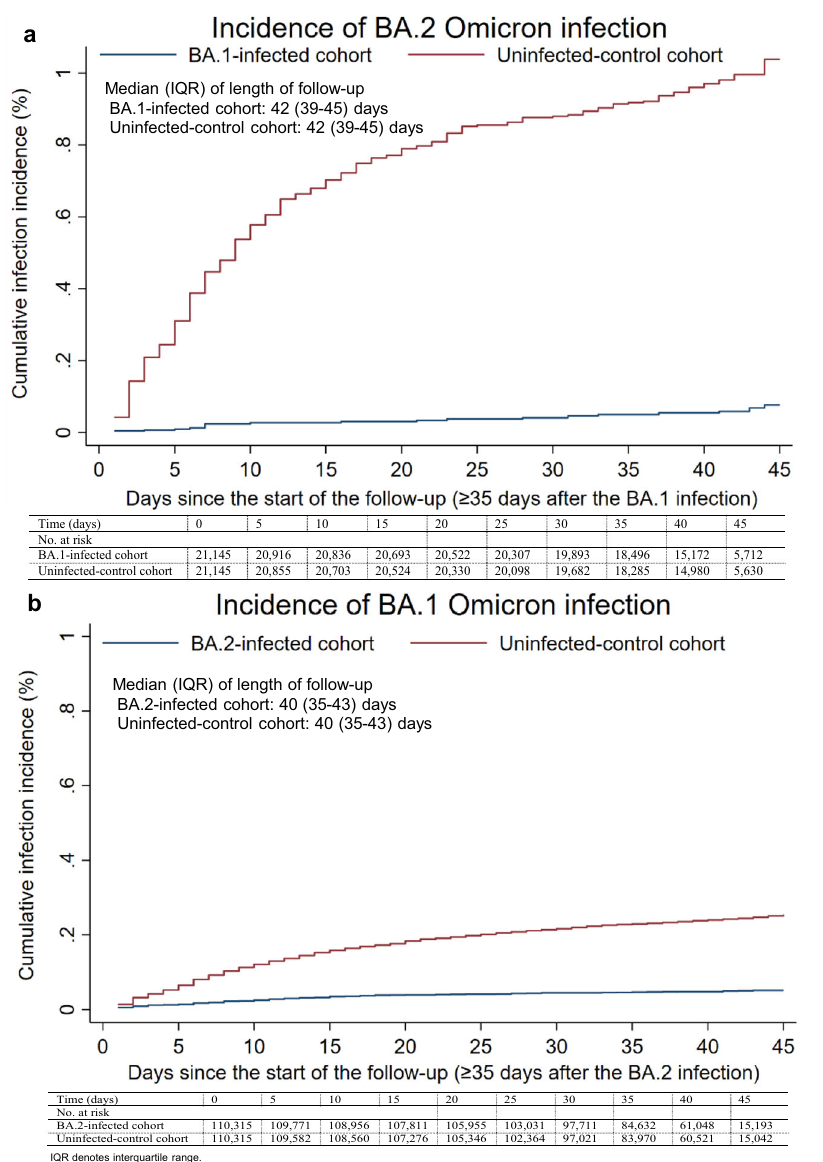
Fig. 3 | Cumulative incidence of Omicron infections in the BA.1-against-BA.2 and BA.2-against-BA.1 studies. Cumulative incidence of a BA.2 and b BA.1 Omi- croninfectionsintheBA.1-against-BA.2andBA.2-against-BA.1studies,respectively.